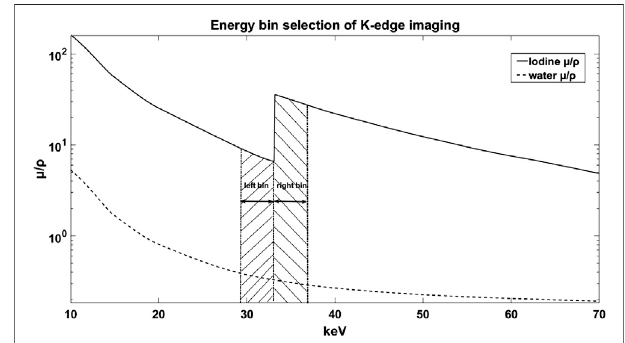
FIGURE 1 | The mass attenuation coef fi cient of water and iodine for x-rays. The shadow parts represent the general energy bins selection for K-edge subtraction imaging.